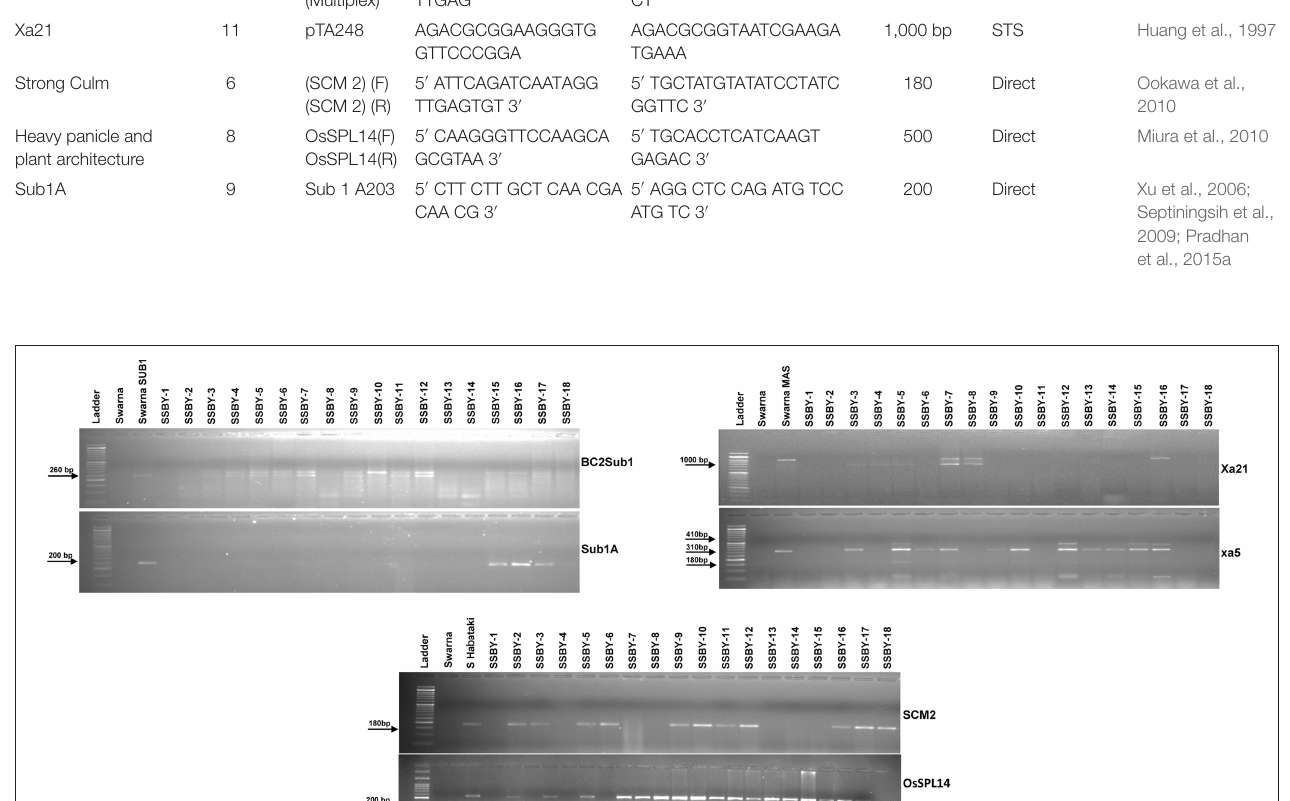
clipping method. First, the scissor was sterilized using 70% ethanol. Then it was dipped into the bacterial suspension, and the upper portion of the test genotype leaf of the plant was cut. Eight BB strains of Odisha state were maintained at NRRI, Cuttack were inoculated to the pyramided and parental lines. At the maximum tillering stage, five leaves from five different plants were inoculated from each entry and replication, and lesion lengths (LL) were recorded after 15 days. The pyramided lines were categorized as resistant (R), moderately resistant (MR), moderately susceptible (MS), and susceptible (S) based on the mean LL. The scoring and classification of pyramided lines were performed as described earlier (Pradhan et al., 2015b, 2019).